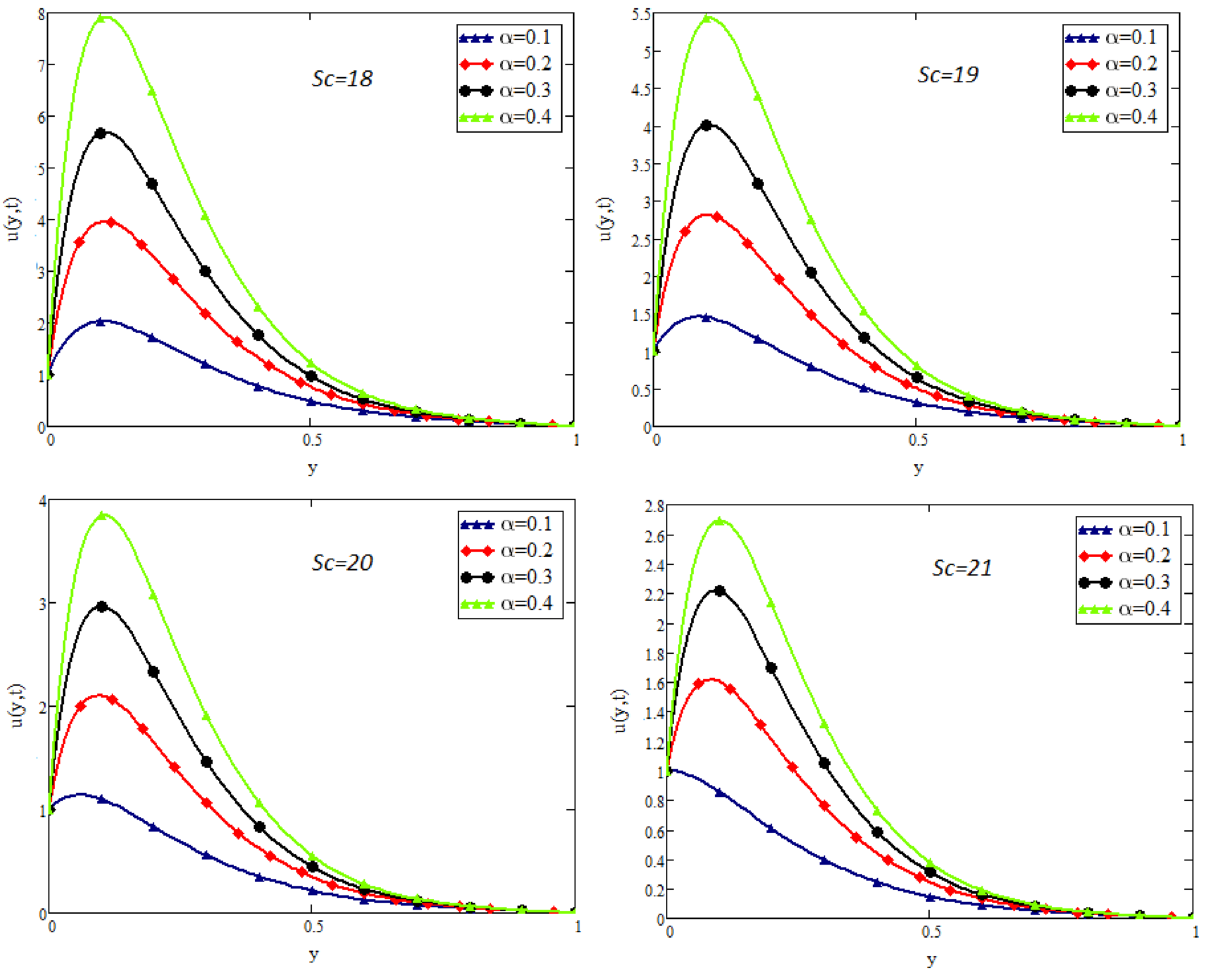
Figure 6. Impact of Sc on velocity distribution t = 1 , Gr = 1.5 , Gm = 1.5 , Pr = 50 , β = 2 , and (cid:31) = 1